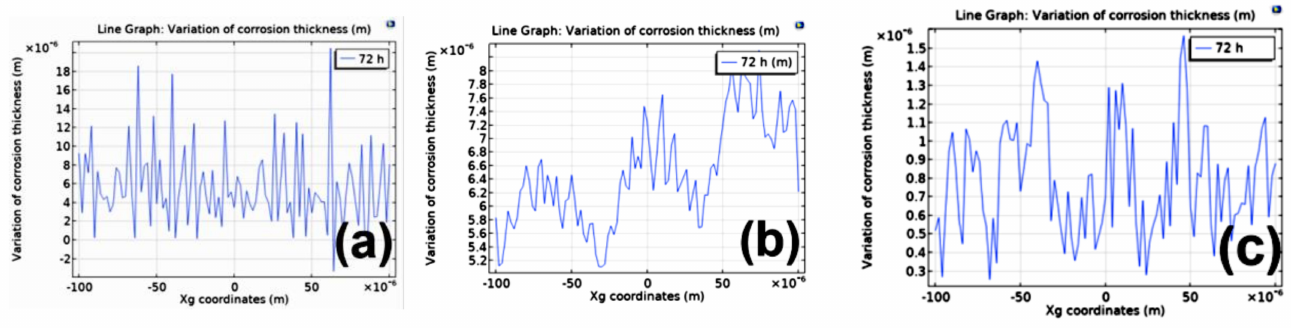
Figure 11. Corrosion thickness curves of COMSOL finite element simulation specimens after 72 h corrosion: ( a ) For specimen #1; ( b ) for specimen #2; ( c ) for specimen